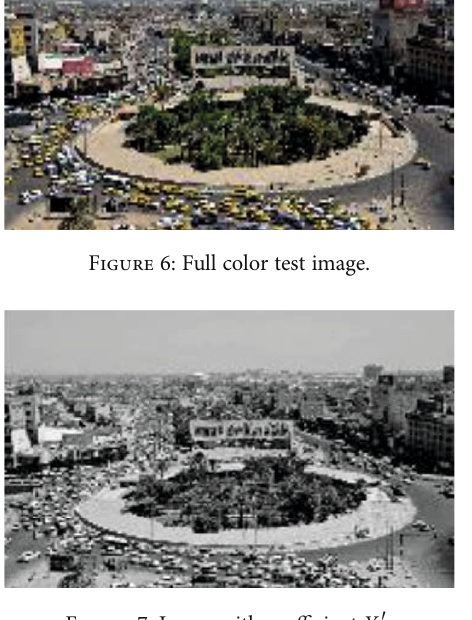
Figure 7: Image with coe ffi cient Y ′ .